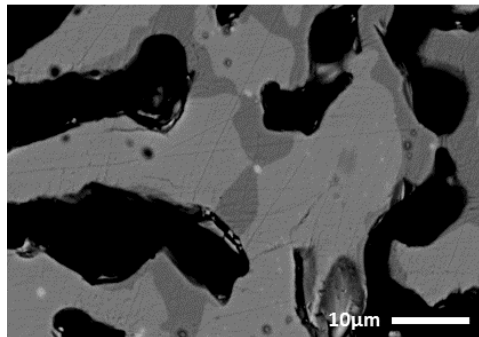
Figure 5. R 12 Fe 3 O 2 phase observed by SEM (dark grey areas) on sintered Terfenol-D with conventional annealing at 1075 °C.